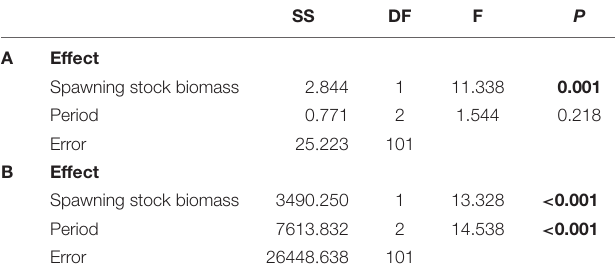
TABLE 1 | Results of the generalized linear model testing (A) the influence of the spawning stock biomass and the type of period (EN, LN, neutral) on the larval settlement of A. atra , and (B) the influence of the spawning stock biomass and the type of period (EN, LN, neutral) on the recruitment of A. atra.